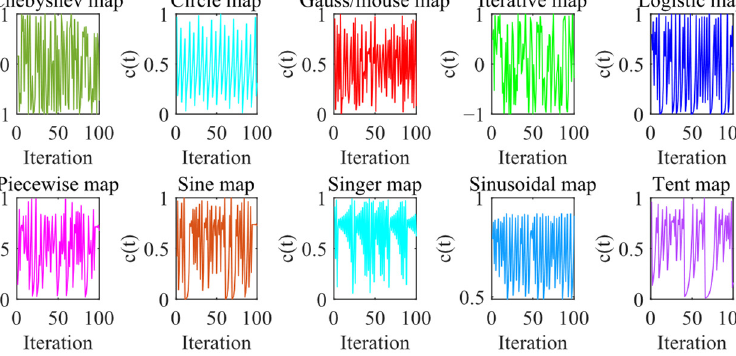
Figure 4. Chaotic mapping image curve.